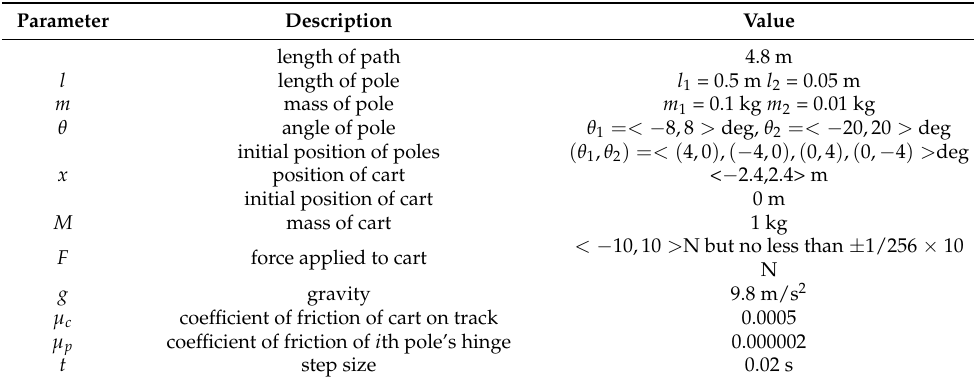
Table 1. Parameter setting for inverted-pendulum